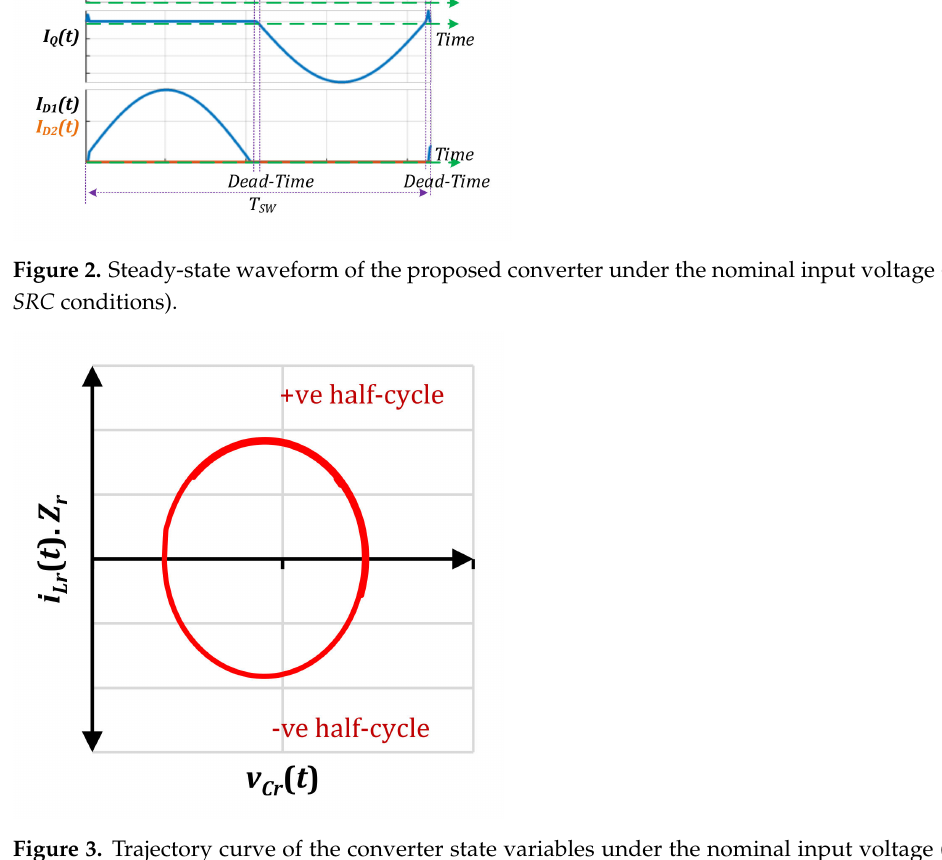
Figure 3. Trajectory curve of the converter state variables under the nominal input voltage ( pure - SRC